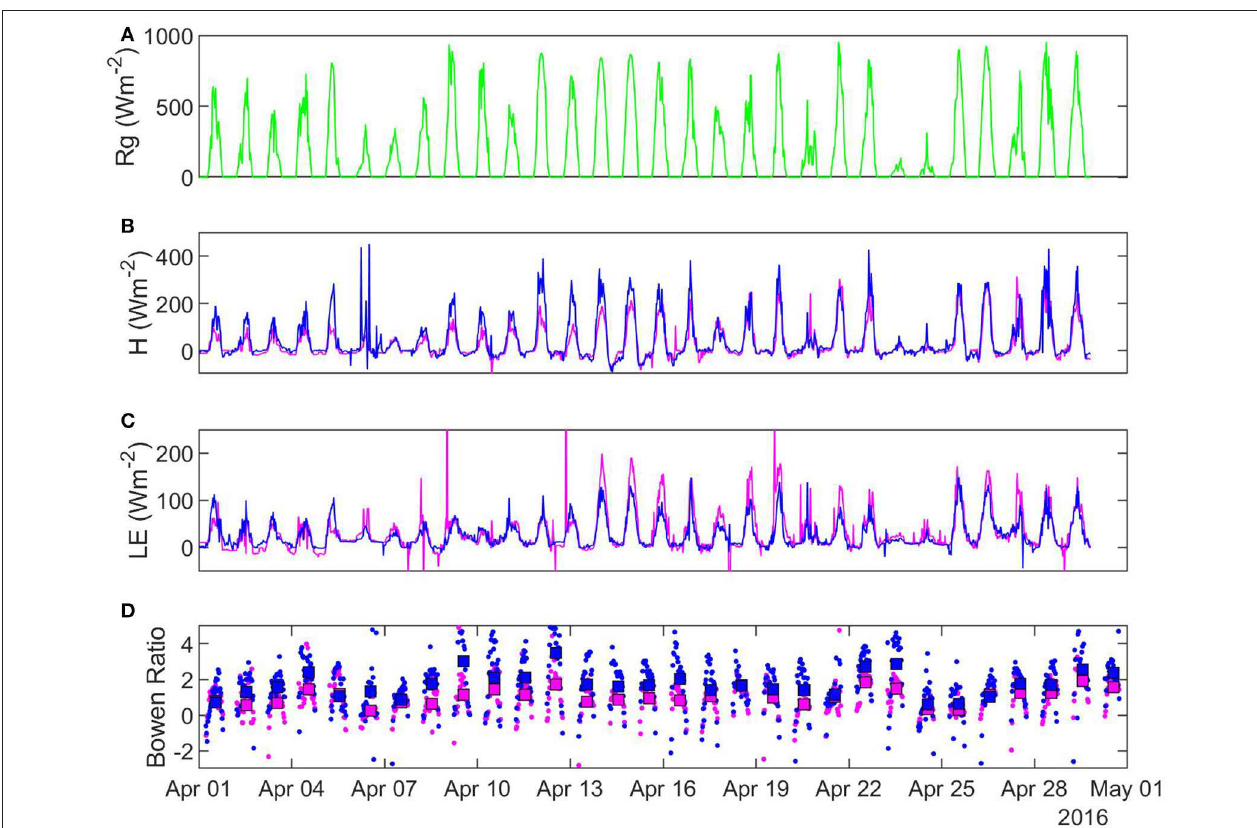
FIGURE 6 | Half-hourly characteristics of selected fluxes in April 2016: (A) solar radiation (B) sensible heat (C) latent heat (D) Bowen ratio. Pink, sheltered fen (US-ALQ); blue, open fen (US-Los); green, Rg for both sites.